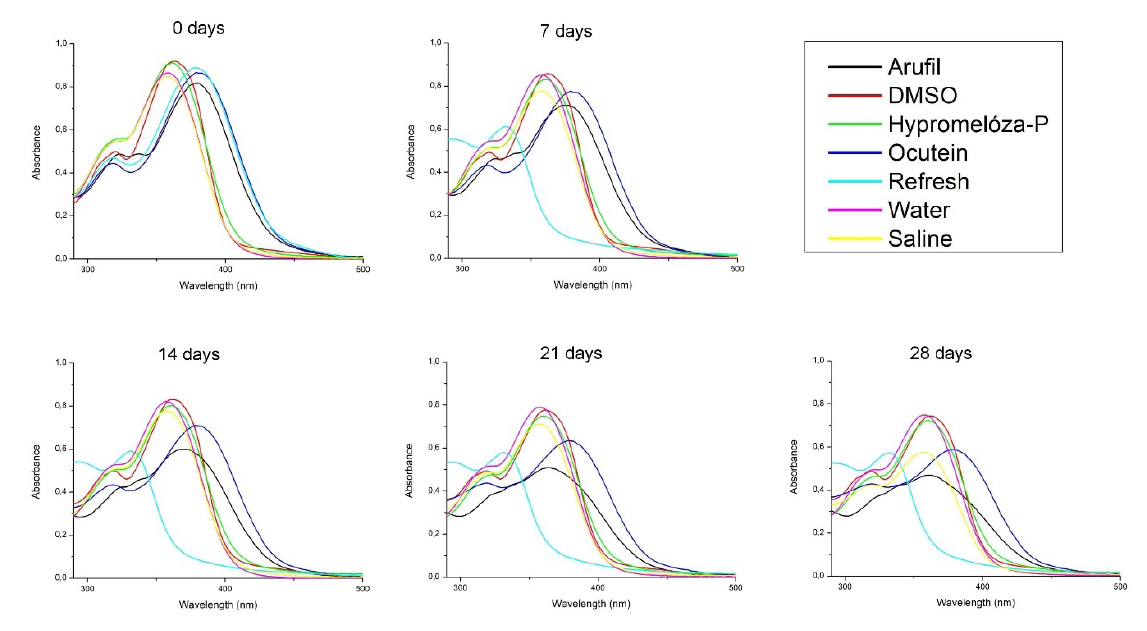
Figure 2: Absorption spectra of 50 M fisetin in eye drops (Arufil, Hypromelóza-P, Ocutein, Refresh), dimethylsulphoxide (DMSO), deionized water and normal saline solution (NSS) during four weeks. Fisetin was dissolved in DMSO (stock solution) and the solution was mixed with the respective volume of eye drops, DMSO, deionized water or NSS to obtain final 50 M fisetin concetration. Absorption spectra of fisetin in eye drops, DMSO, deionized water and NSS have been measured on the day of solutions preparation (0 days), after 7, 14, 21 and 28 days.